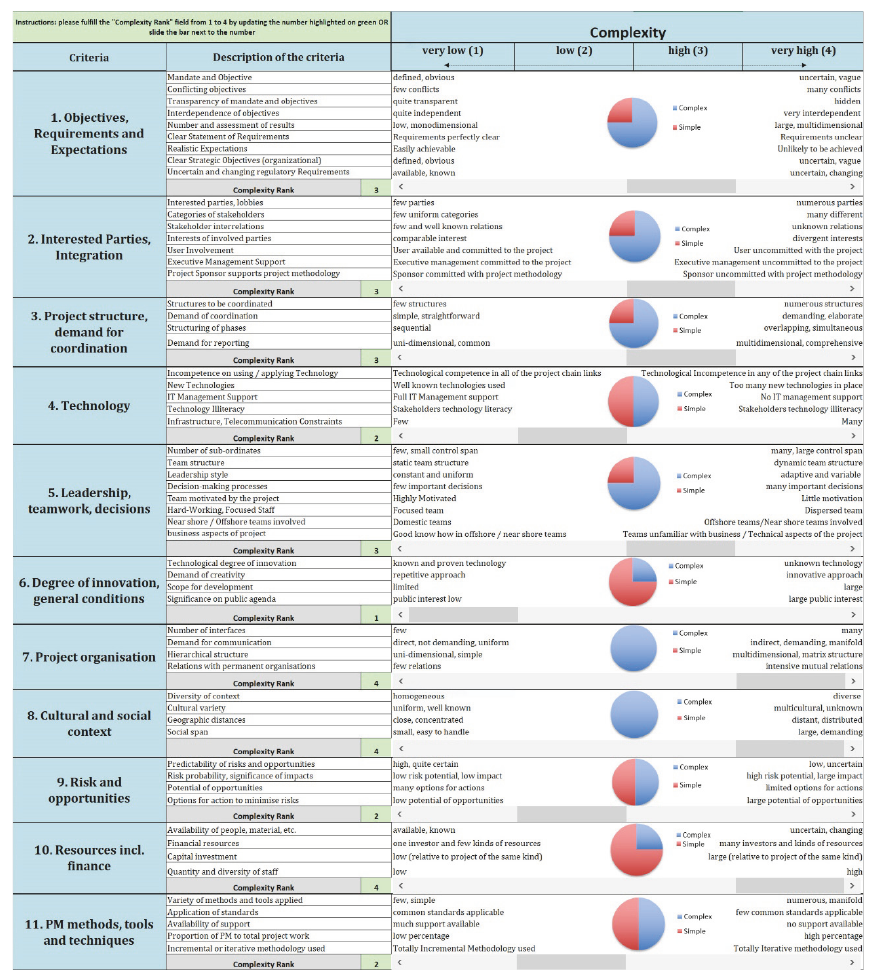
Figure 11: 2016 project assessment with Complexity Index tool.